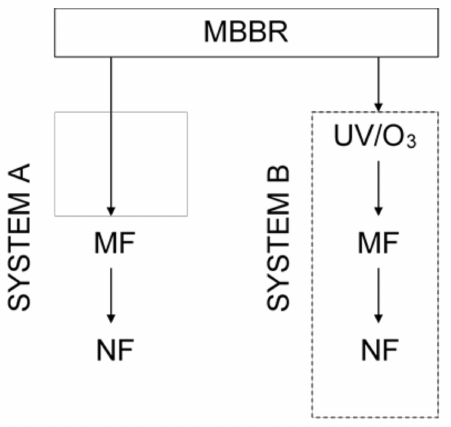
Figure 2. A scheme of the procedure of the treatment of laundry wastewater in systems A and